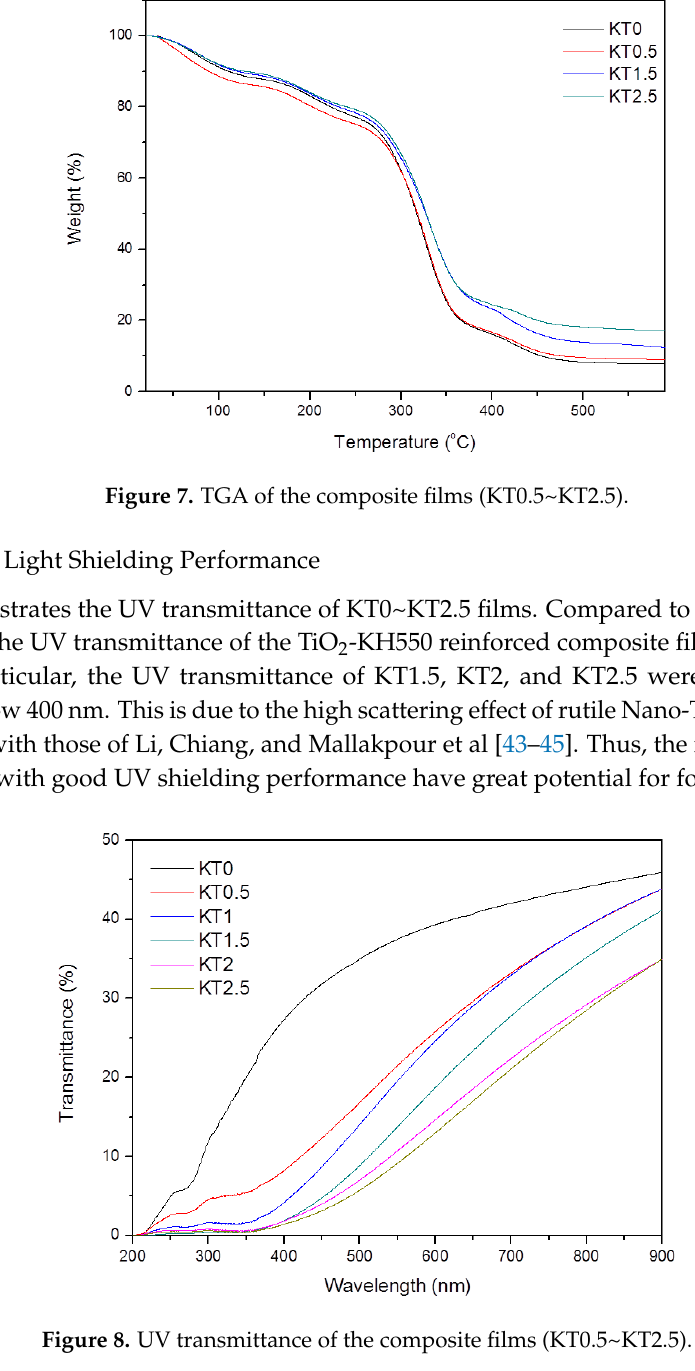
Figure 6. Moisture absorption of the composite films (KT0.5~KT2.5). 3.2.4. Thermal Stability The thermal stability of KT0, KT0.5, KT1.5, and KT2.5 was illustrated in Figure 7. The weight loss of the composite films was divided into the following four stages: 30~120 °C, 120~220 °C, 220~380 °C, and 380~470 °C. The mass loss below 120 °C was due to the evaporation of water in the film, whereas the degradation of the glycerol small molecule occurred mainly in the range of 120~220 °C.